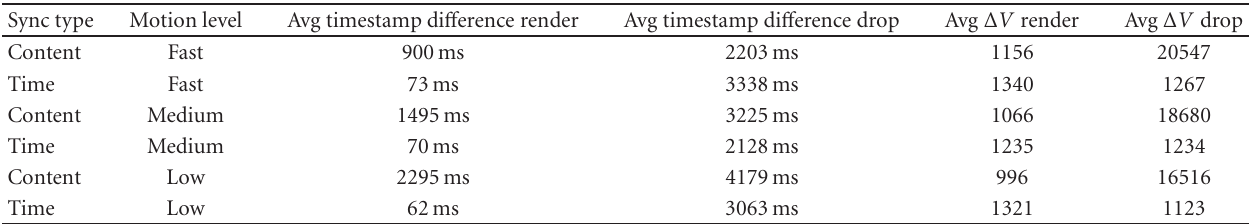
Table 3: Performance results of content-based and time-based synchronization algorithms obtained for videos with di ff erent levels of activities.